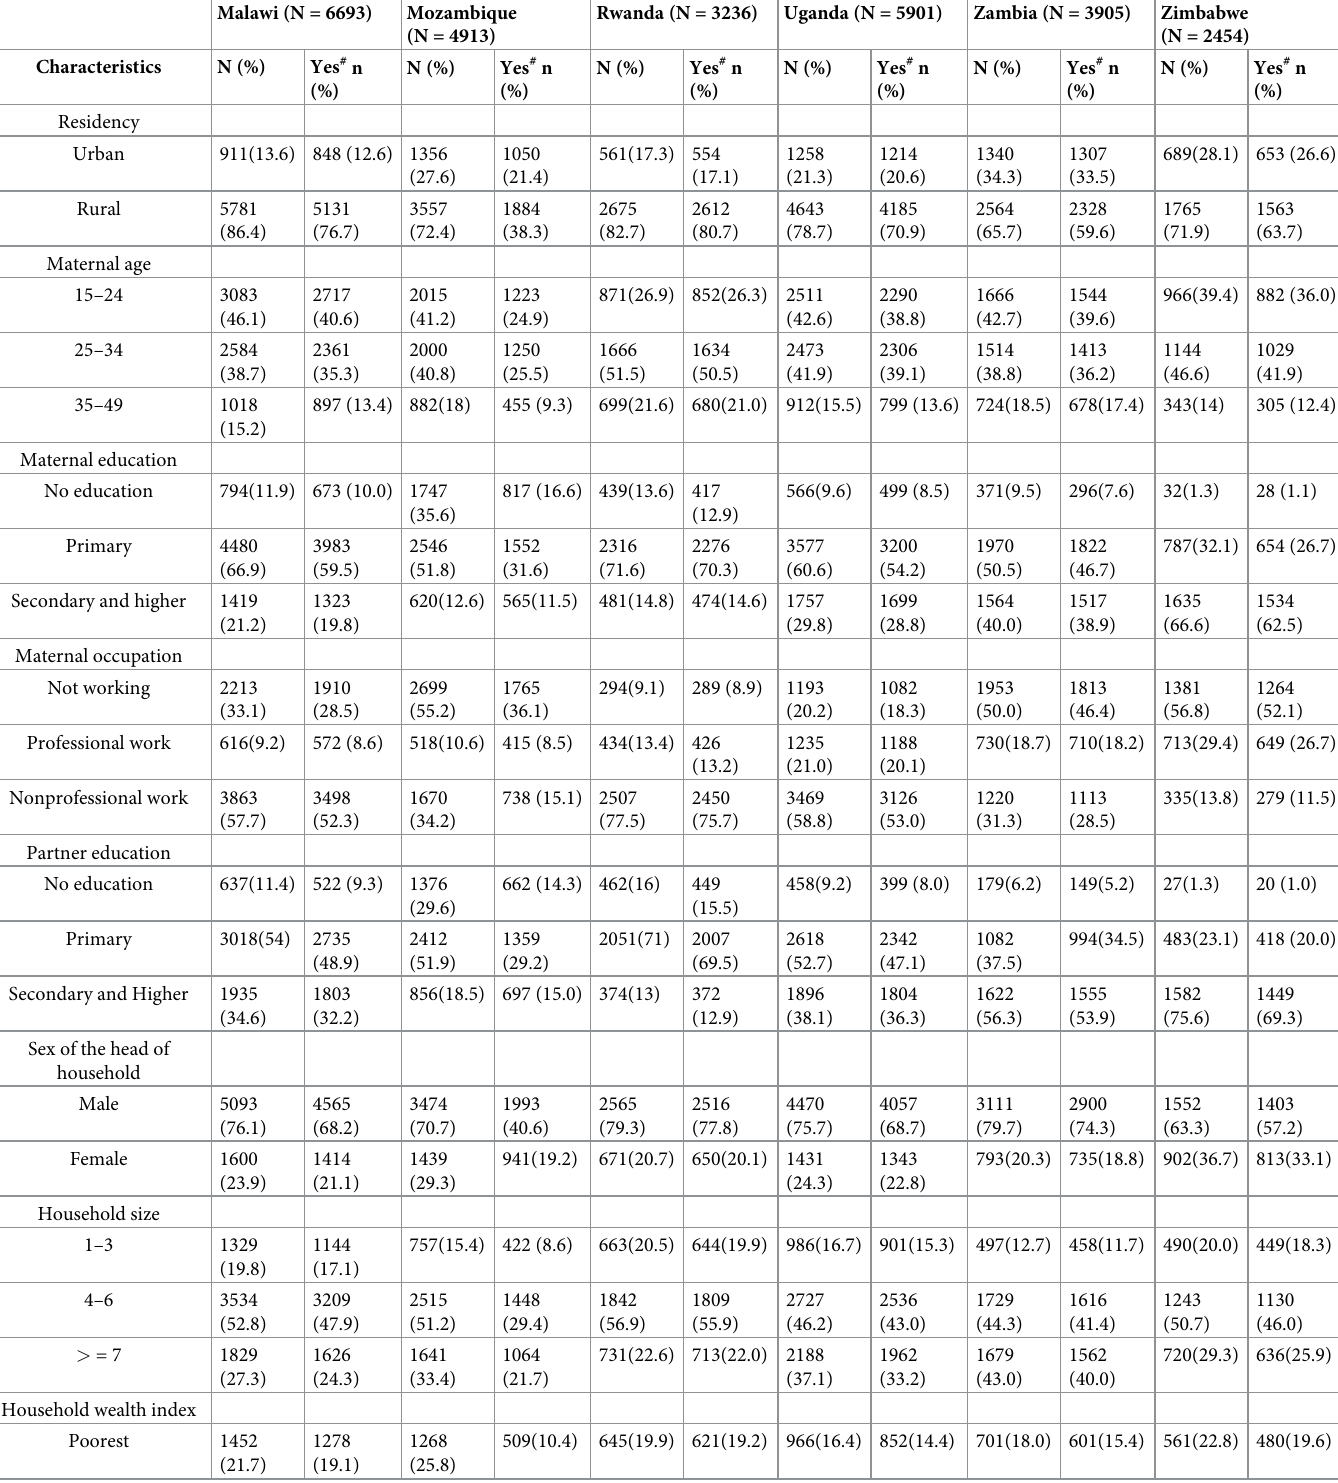
Table 2. Study participants characteristics and percentage of prenatal HIV test service users for PMTCT by study factors in East African countries (N = 45,476; Demographic and Health Survey, 2011–2018). Malawi (N = 6693) Zambia (N = 3905) Zimbabwe